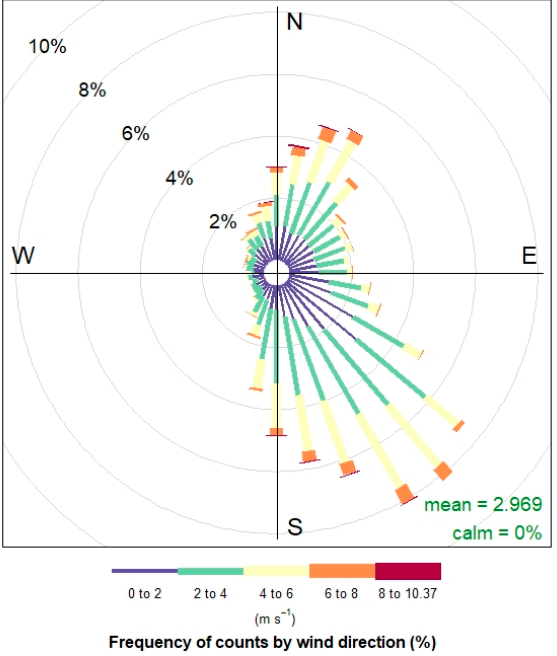
Figure 3. Wind rose based on meteorological measurements at the TCEQ Karnes City air quality monitor from combined 2019–2020 data.